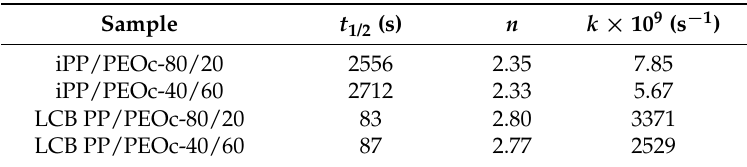
Figure 6. The Avrami plots for iPP/PEOc and LCB PP/PEOc blends isothermally crystallized at 140 °C. Table 1. t 1/2 and Avrami parameters for the iPP/PEOc and LCB PP/PEOc blends undergoing isothermal crystallization at 140 °C.